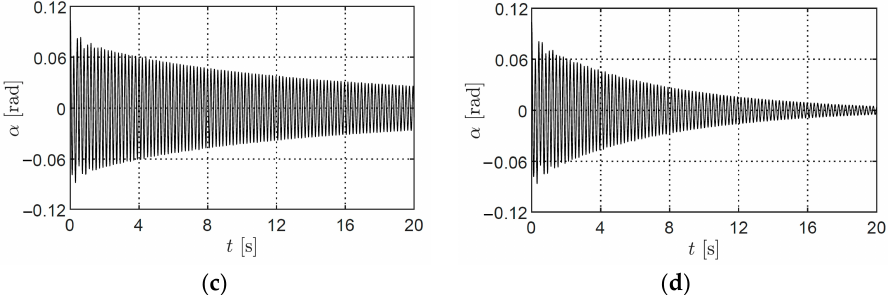
Figure 20. Torsional=dominant coupled responses from Setup 1: ( a ) vertical displacement at U = 0 m/s; ( b ) vertical displacement at U = 10 m/s; ( c ) torsional displacement at U = 0 m/s; ( d ) torsional displacement at U = 10 m/s.